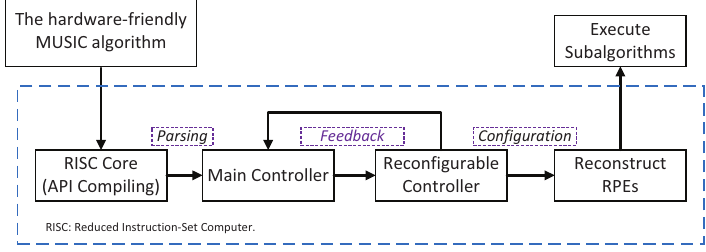
Figure 2. The configuration process of the accelerator.